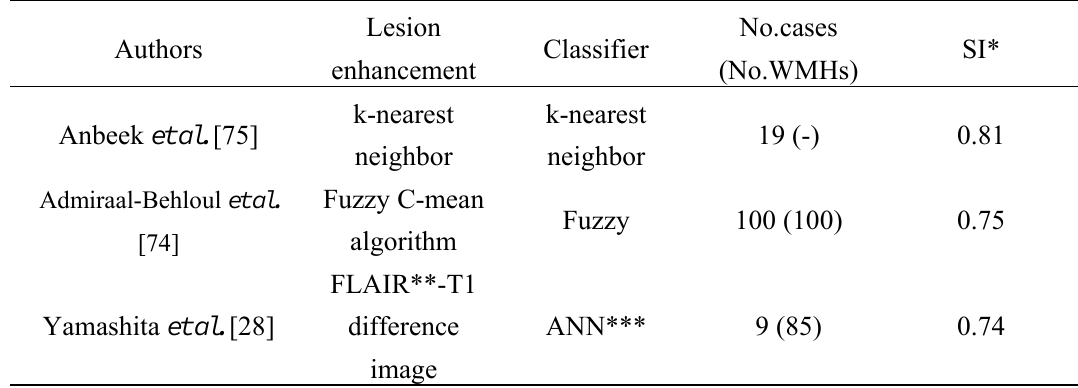
Table 2. Comparison of methods and performance of CAD systems for detection of white matter hyperintensities (WMHs) in MR images.